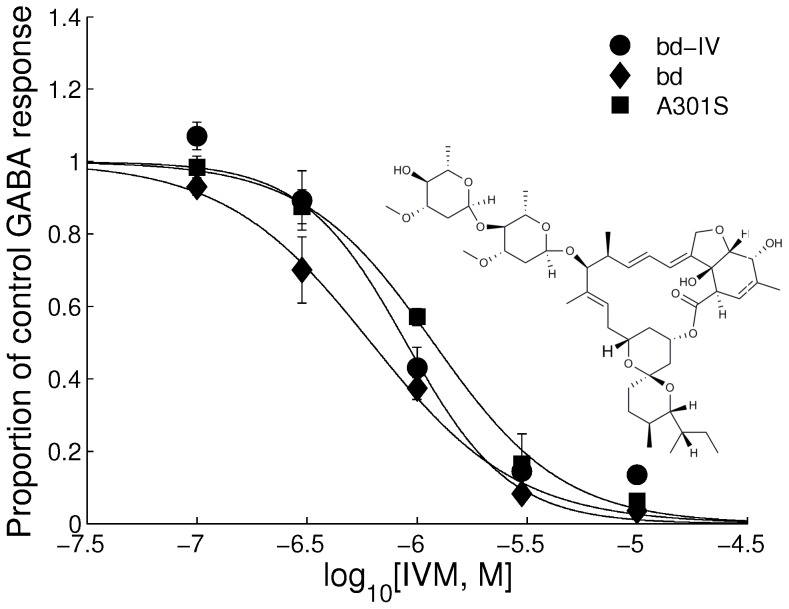
Effect of ivermectin on RDLbd.Concentration inhibition curves showing responses elicited by IVM to 100 µM GABA in wild-type, RDLbdIV and RDLbdIV/A301S. Each point represents the mean amplitude of the responses recorded in 2–6 oocytes from at least 3 separate batches. The structure of ivermectin is inserted.